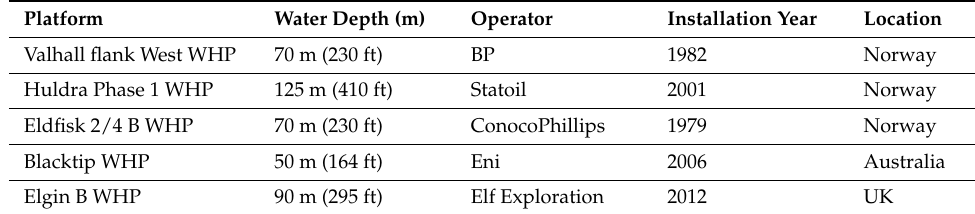
Table 8. List of some wellhead jacket platforms (WHP)